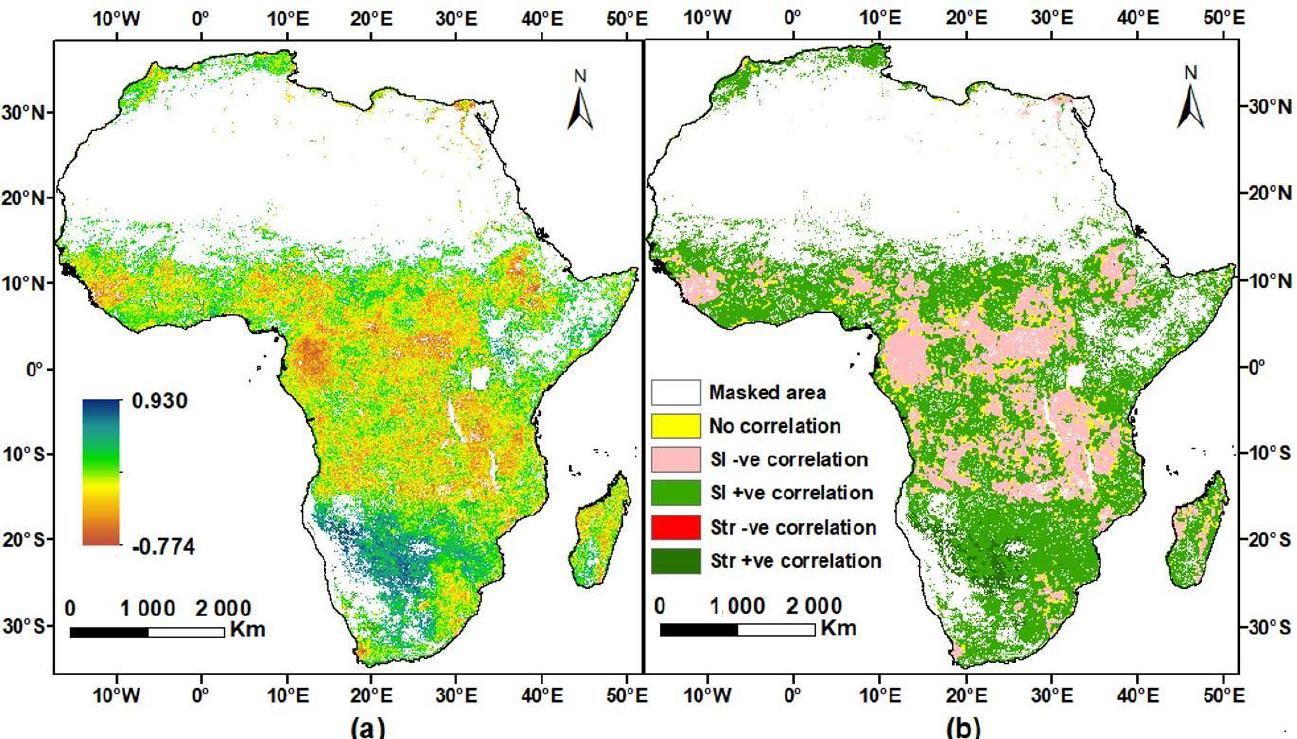
Figure 8. Consistency Between NDVI3g and Precipitation interannual variation in all African climate zones in 34 years of the study.